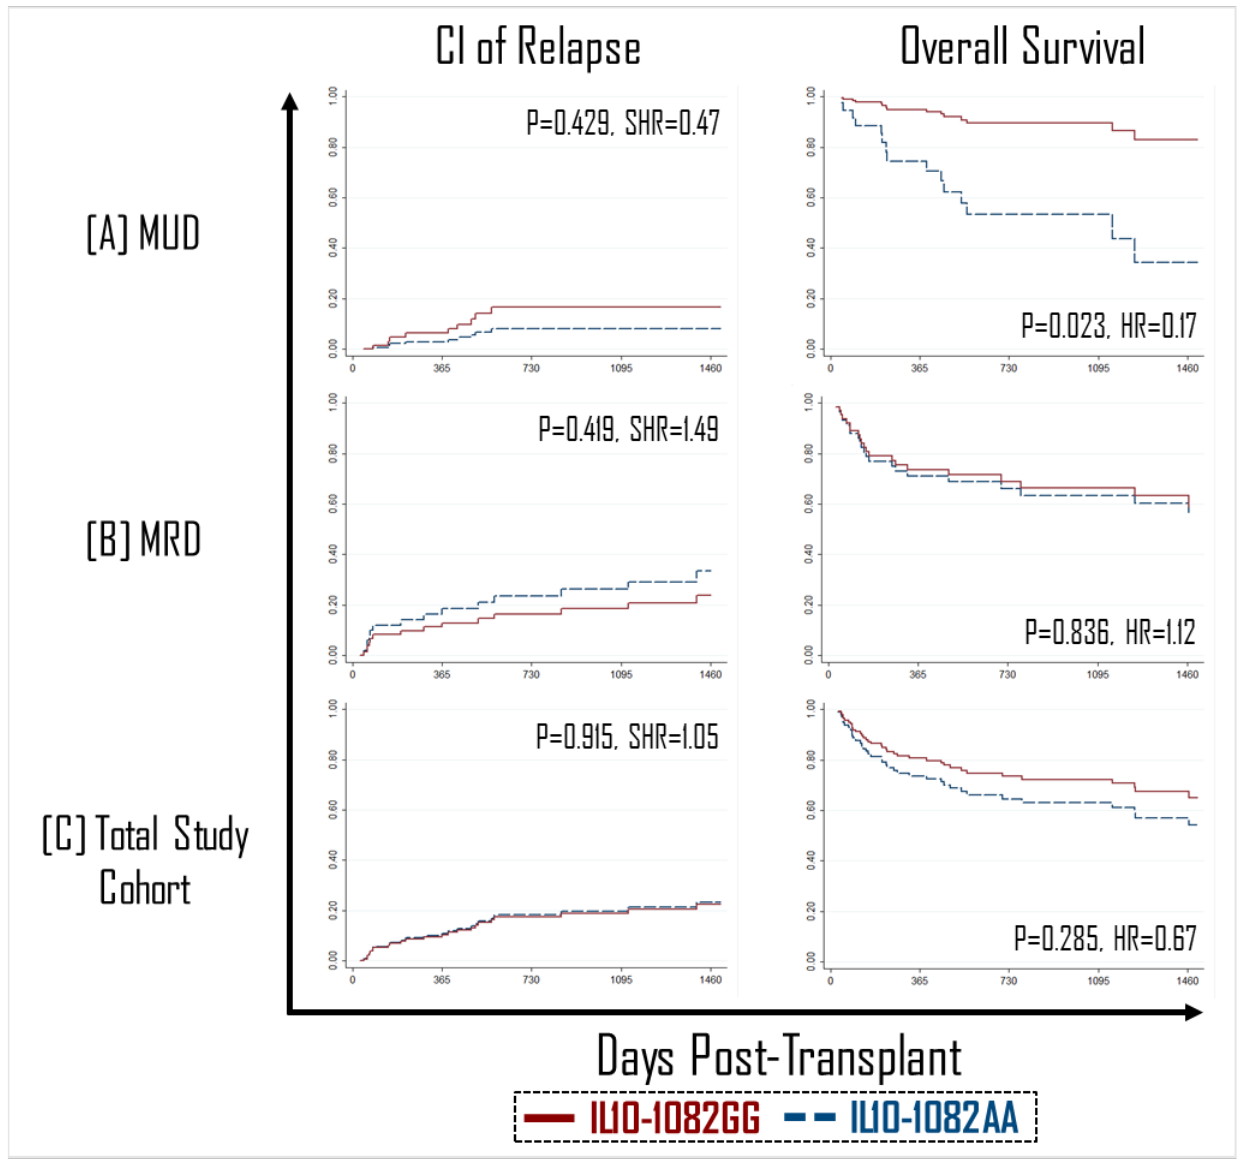
Figure 2. No impact of IL10-1082 polymorphisms was observed on the cumulative incidence (CI) of relapse ( left panel , ( A – C )). HCT recipients with an IL10-1082GG graft had improved overall survival in matched unrelated donor (MUD) transplants ( right panel , ( A )), but not matched unrelated donor (MRD) ( right panel , ( B )).